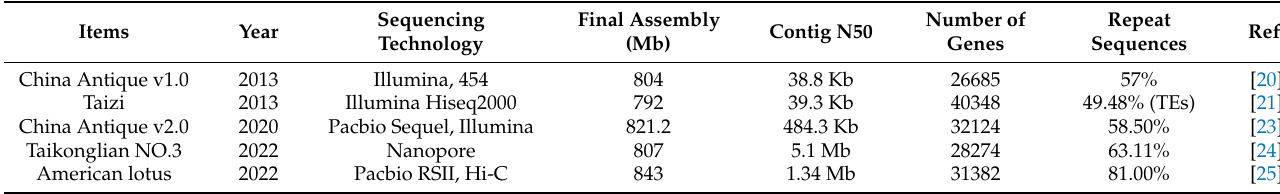
Table 1. Comparison of assembled lotus